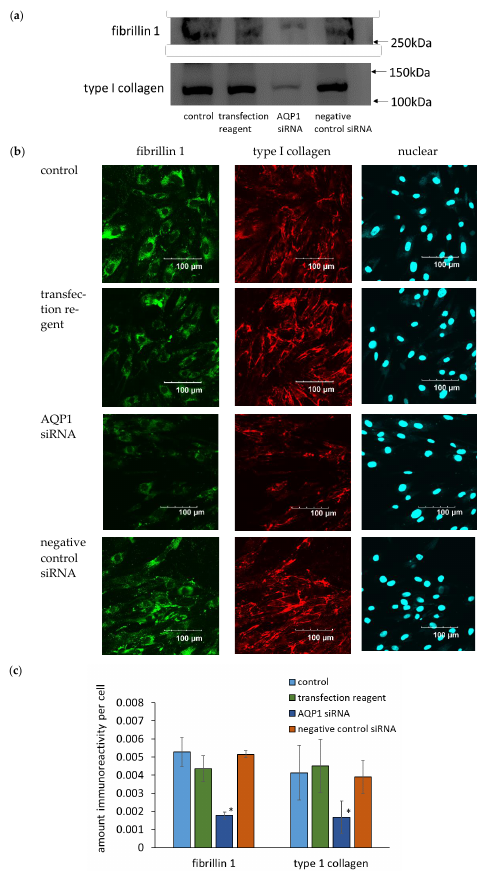
Figure 6. ( a ) Western blotting for fibrillin 1 and type I collagen in cultured human dermal fibroblasts following AQP1 depletion by AQP1 siRNA. ( b ) Antibody staining for fibrillin 1 and type I collagen in cultured human dermal fibroblasts after AQP1 depletion by AQP1 siRNA. ( c ) Image analysis of the amount of immunoreactivity per cell using ImageJ. *: p < 0.05 vs. the transfection reagent. The figure shows the means ± standard deviations ( n = 3). 3.7. mRNA Levels of Fibrillin 1 and Type I Collagen in Human Dermal Fibroblasts Depleted of AQP1 by AQP1 siRNA RNA extracted from collagen gels containing cultured human dermal fibroblasts in which AQP1 was depleted was analyzed by real-time PCR. AQP1 siRNA significantly decreased the amount of AQP1 mRNA, indicating that the depletion was properly per- formed. We also found that the mRNA levels of fibrillin 1 and type I collagen were signifi- cantly decreased in cultured human dermal fibroblasts in which AQP1 was depleted (Fig- ure 7).